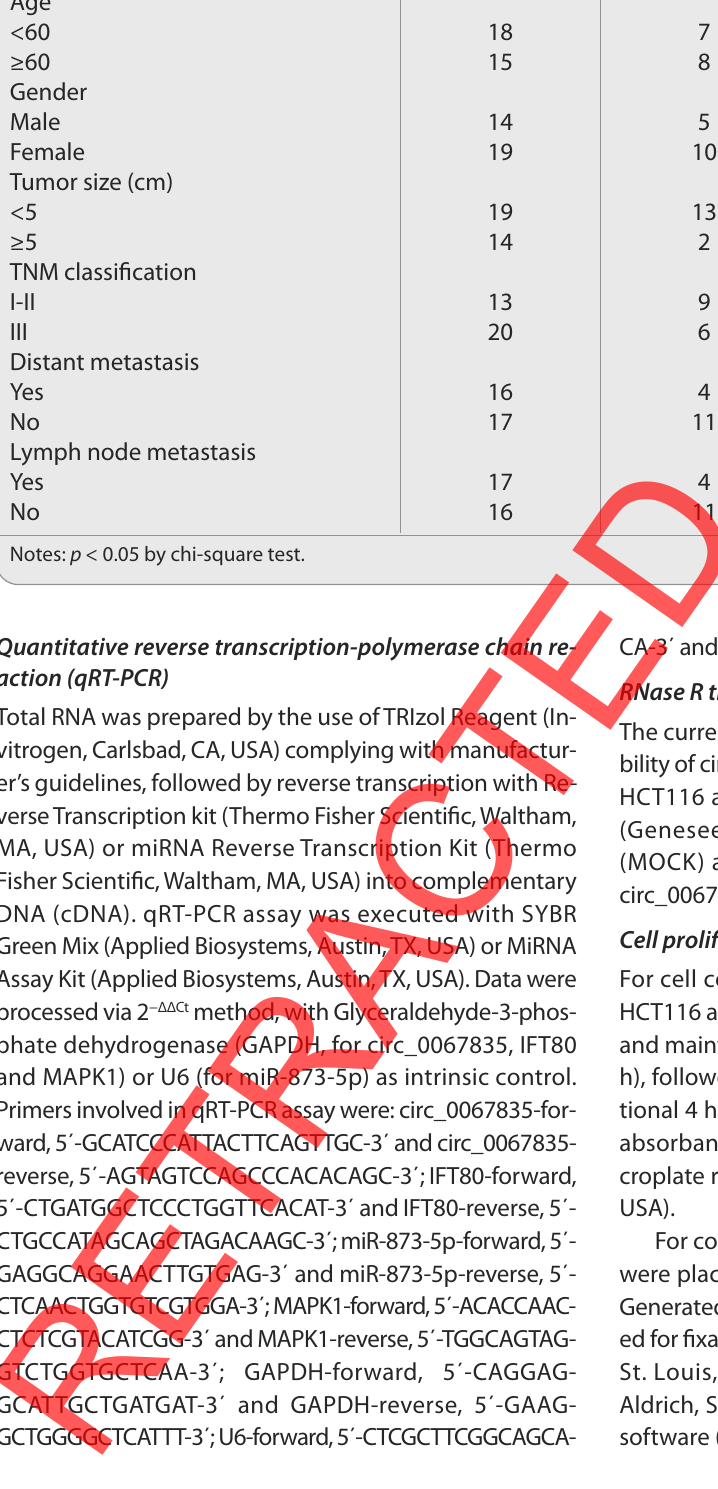
Table 1. Correlation between circ_0067835 expression and clinical features of colorectal cancer patients Clinical